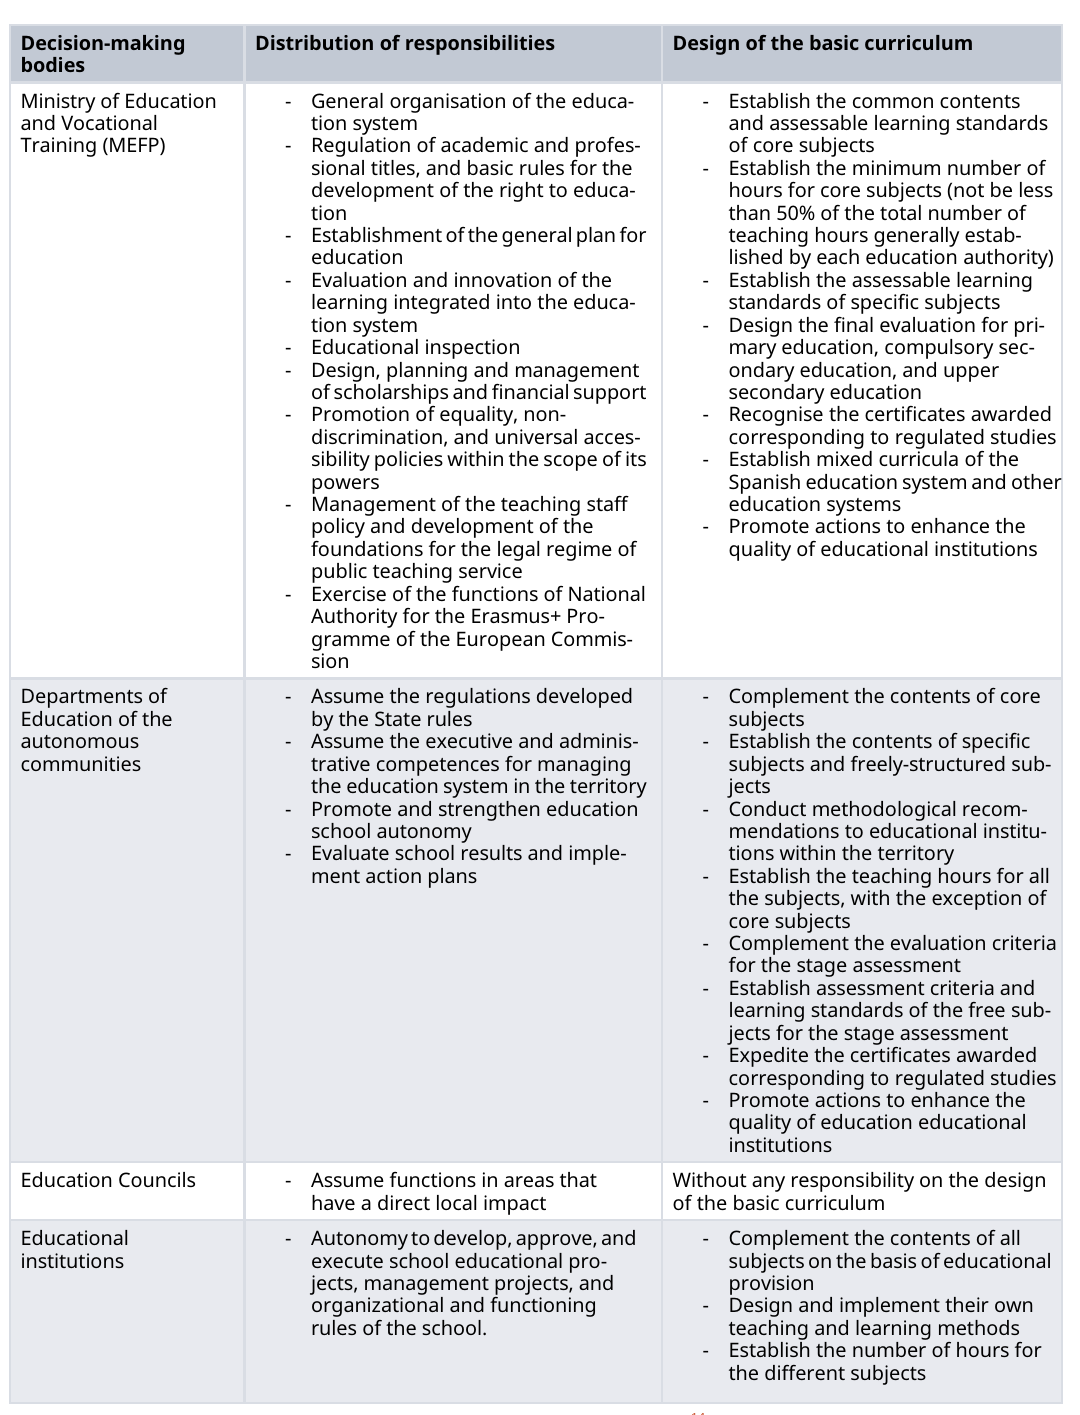
Table 1. Distribution of responsibilities between levels of government in Spanish education